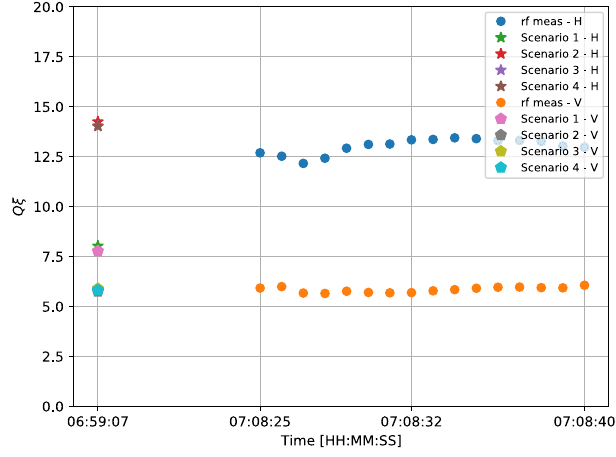
FIG. 7. Chromaticity measurements during LHC fill 7435.